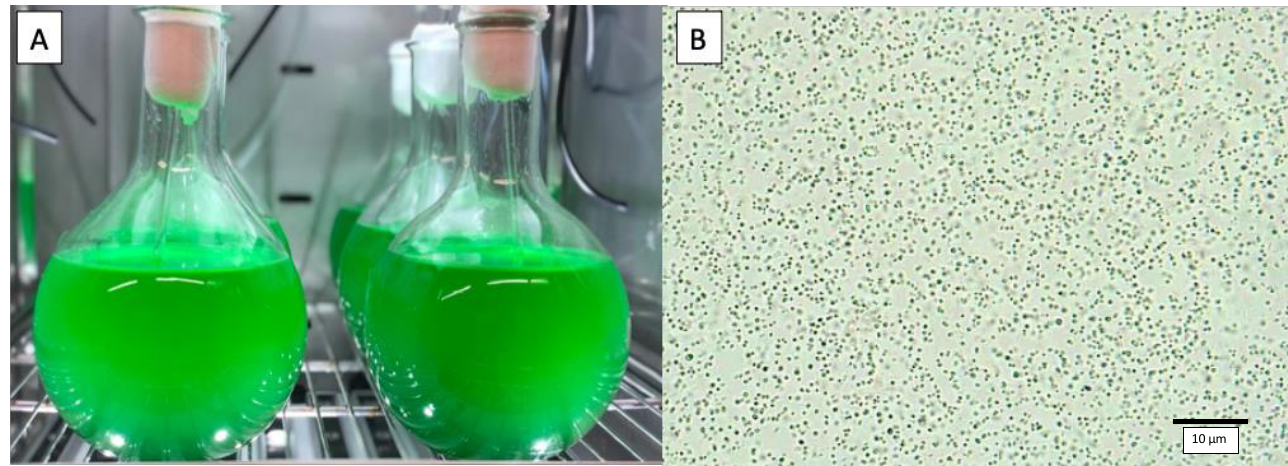
Figure 2. Cyanobium sp. LEGE 06113 culture. ( A ) 2 L round flask during optimization trials ( B ) Optical microscope view (400 ×